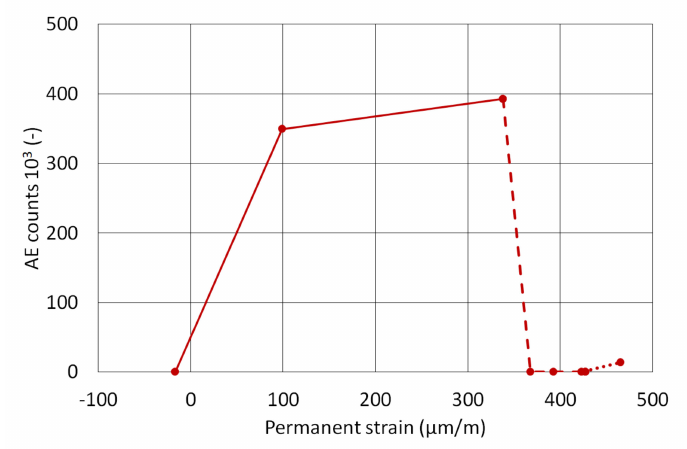
Figure 7. Dependence of AE counts on the development of permanent strain in the concrete